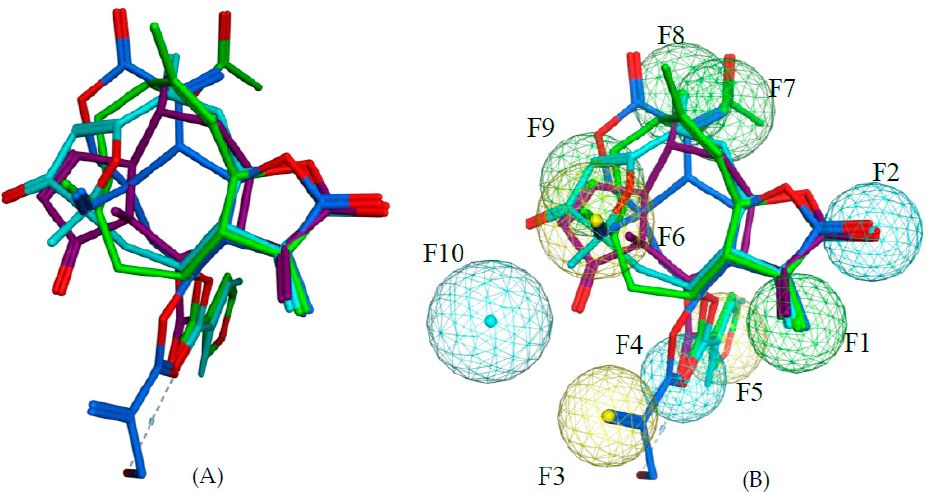
Figure 3. ( A ) Alignment as obtained by the flexible alignment function of MOE based on pharmacophoric atom properties; violet: 2 , light blue: 73 , green: 97, and blue: 111 . ( B ) Common pharmacophore features of 2 , 73 , 97 , and 111 . Pharmacophore spheres: blue: hydrogen bond acceptor; yellow: hydrophobe; green: reactive carbon of α , β or α , β , γ , δ -unsaturated carbonyl groups. The features F1 – F10 are numbered as used in the QSAR modeling.